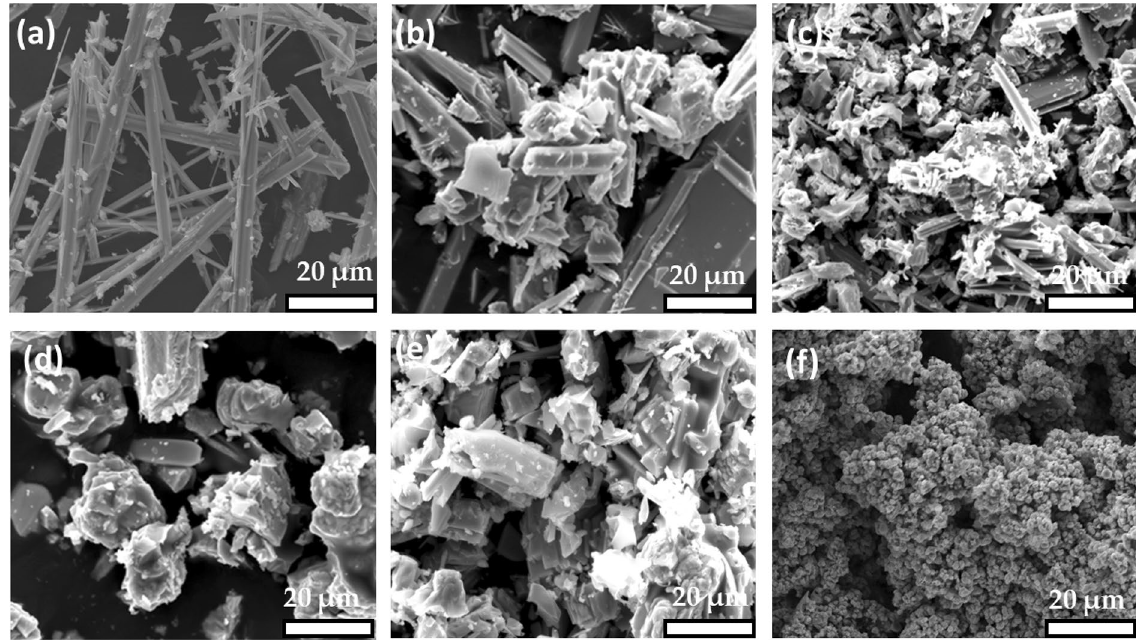
Figure 2. Representative SEM images of particulate Cu 2x Sb 2(1−x) S y prepared by solventless thermolysis at 450 °C for 1 h where x = ( a ) 0, ( b ) 0.2, ( c ) 0.4, ( d ) 0.6, ( e ) 0.8 and ( f ) 1. These were recorded at 15 k eV using secondary electron